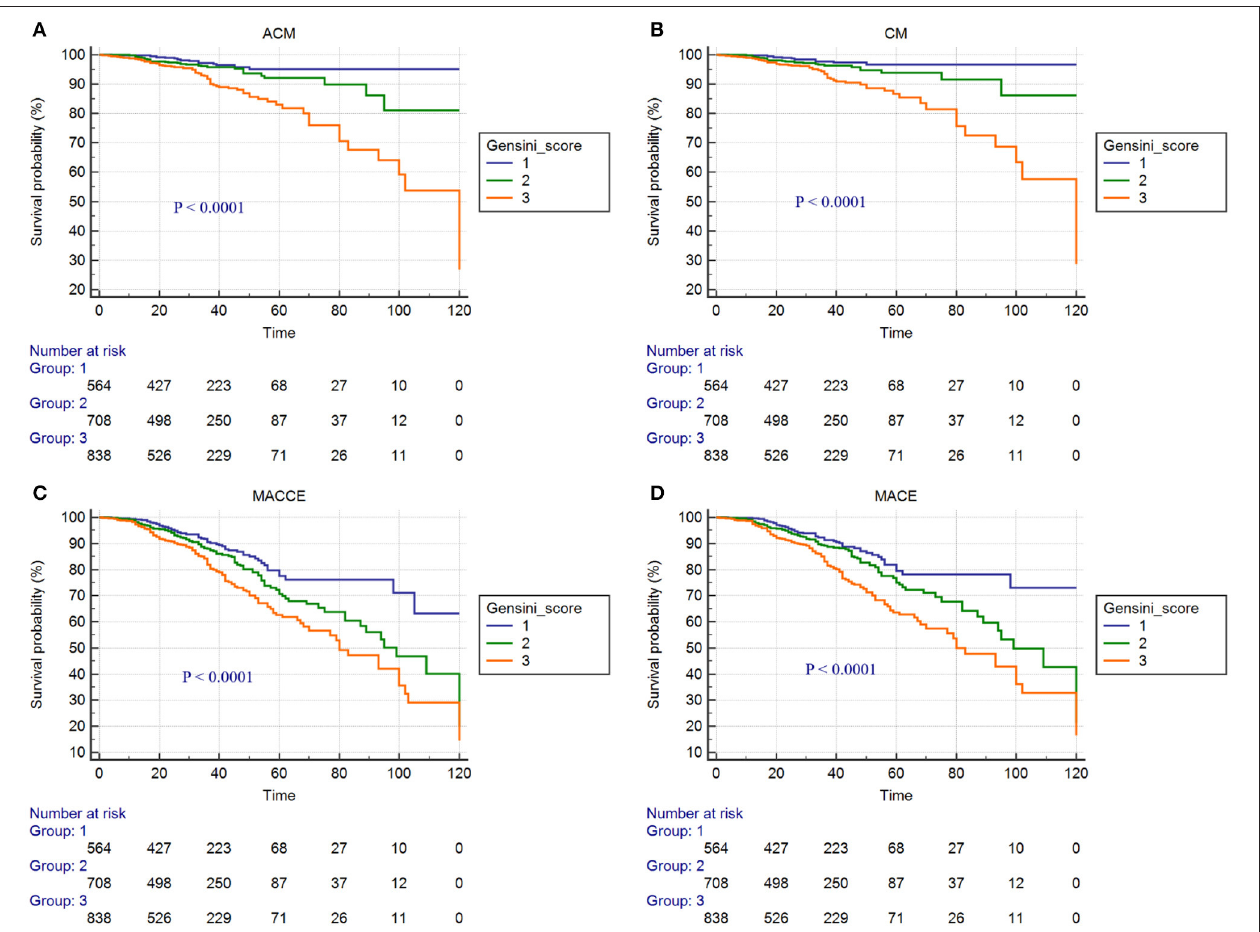
FIGURE 4 | Cumulative Kaplan-Meier estimates of the time to the first adjudicated occurrence of primary endpoints and secondary endpoints: (A) ACM; (B) CM; (C) MACCEs; (D) MACEs. (In the 2,110 CAD patients with